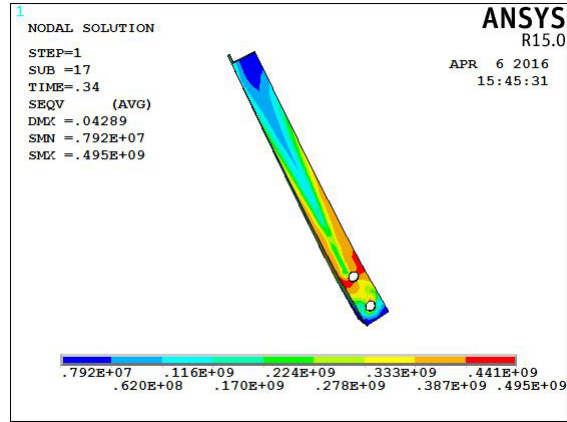
Figure 8: Equivalent stress nephogram of left secondary angle